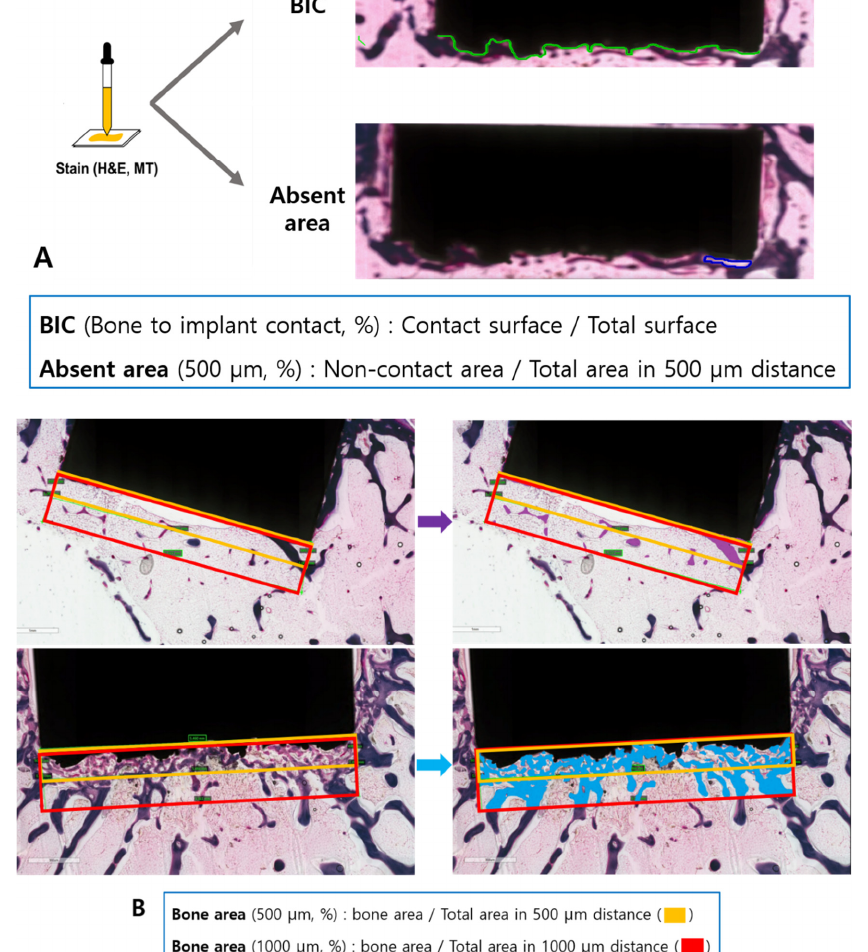
Figure 4. After the staining procedures, we performed bone histomorphometry using four methods. A : (1) Bone-to-implant contact (BIC): determination of the percentage of direct contact surface between the mineralized bone and the surface of the CoCr alloy; (2) absent area: determination of the percentage of non-contact area between the total area in a 500 µ m region. B : (3) bone area (500 µ m): determination of the percentage of new bone formation and neovascularization area between the total area in a 500 µ m region; 4) bone area (1000 µ m): determination of the percentage of new bone formation and neovascularization area between the total area in a 1000 µ m